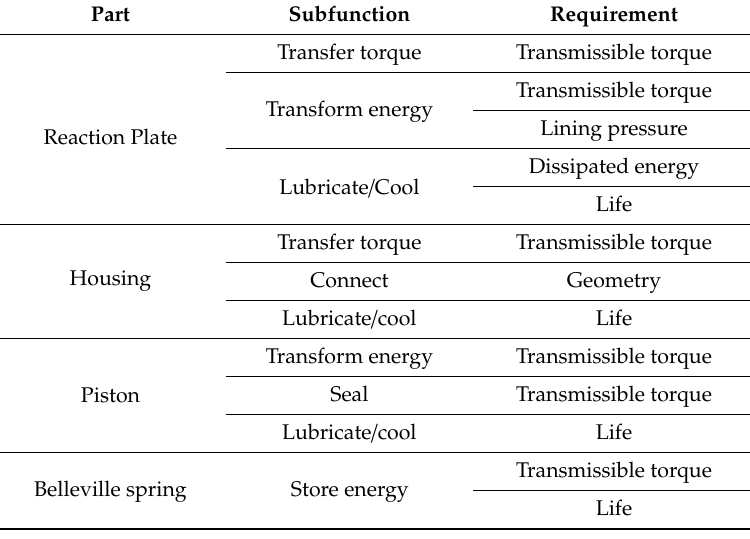
Table 1. Clutch parts linked to the requirements through the subfunctions they deliver (extract).